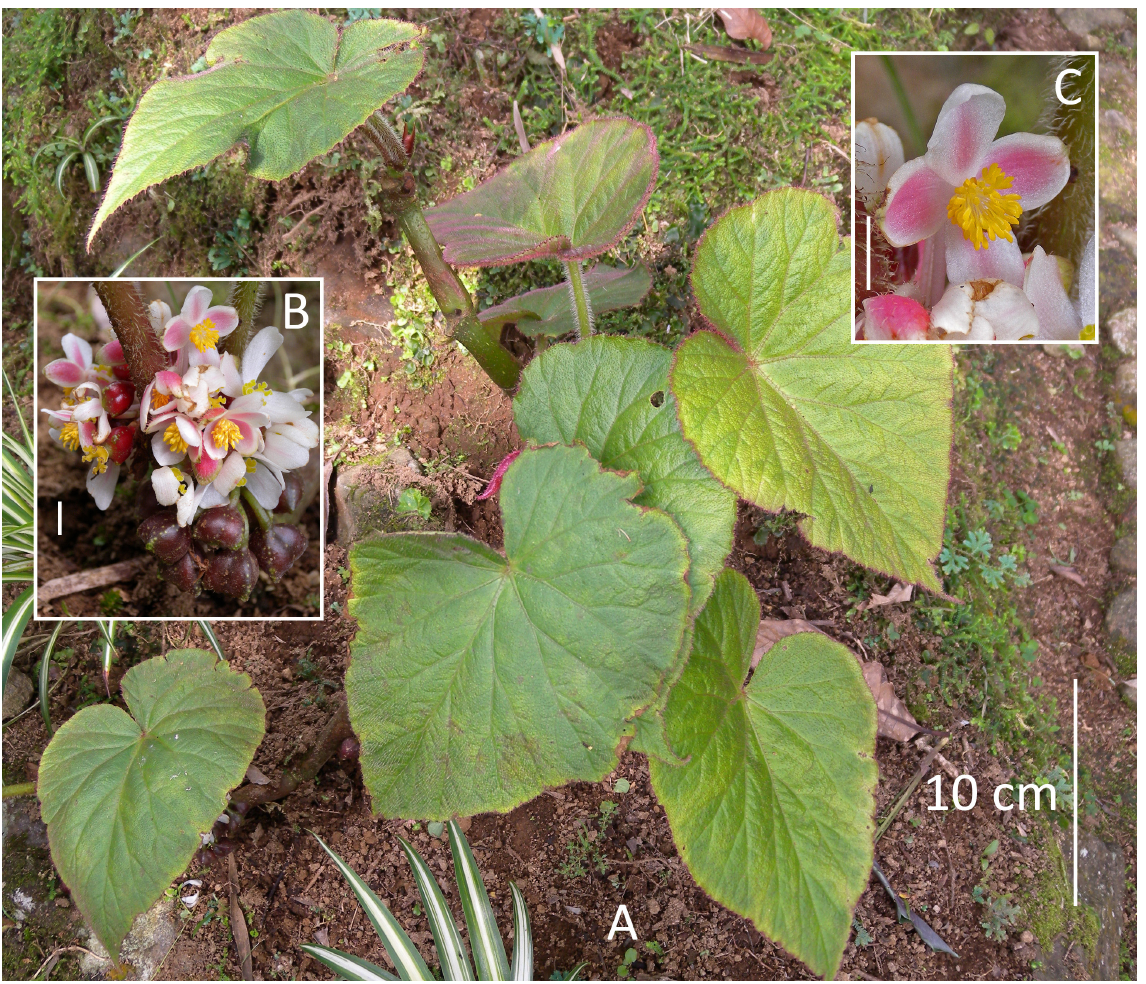
Fig. 15. Begonia pseudoscottii Girm sp. nov. A . Habit. B . Inflorescence at the base of the plant, with mature fruit below and male and female flowers open at the top. C . Male flower. All photographs from a plant cultivated in Cibodas Botanic Garden (accession number C20090980/IY80, derived from material collected in Gunung Leuser National Park). Scale bars on insets = 1